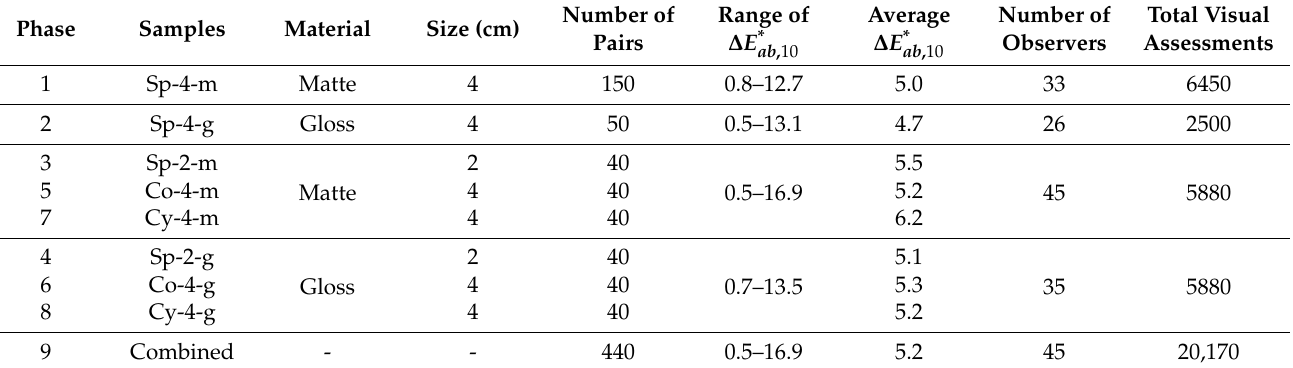
Table 1. Main characteristics of the eight phases in the experiments reported in